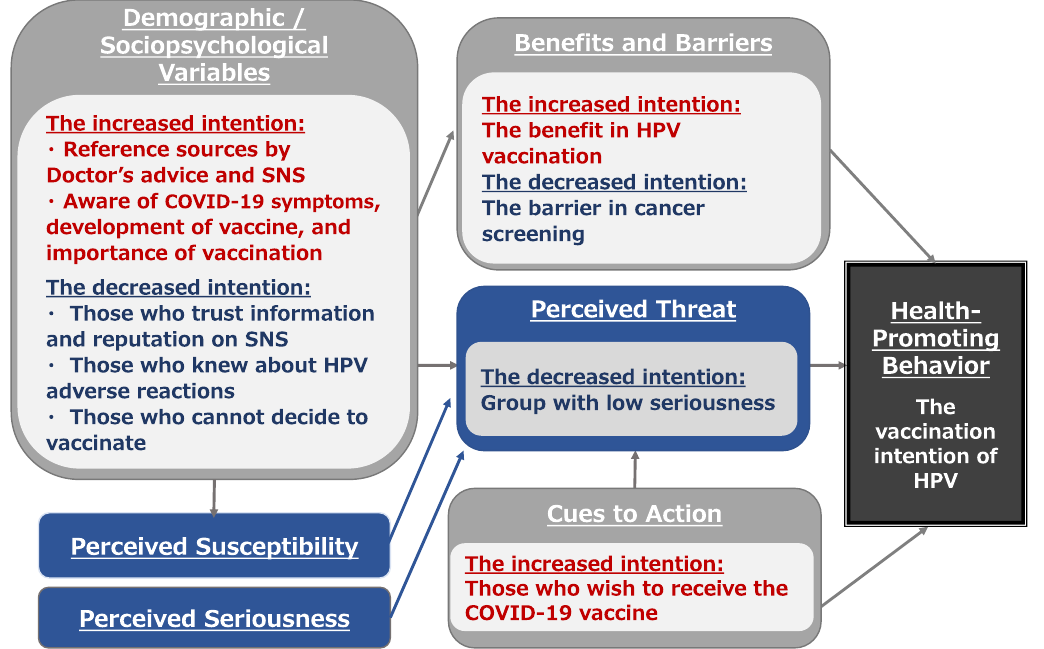
Figure 3. HBM variables could potentially affect people’s acceptance of receiving an HPV vaccine.